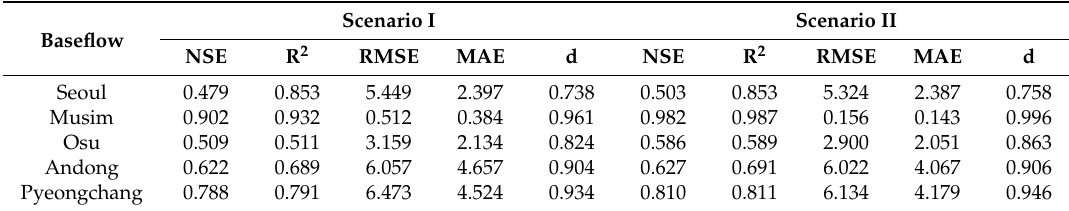
Figure 6. Observed and simulated streamflow recessions for five study watersheds. Table 5. Comparison of baseflow results for Scenarios I and II after separation of baseflow from SWAT-modeled streamflow using